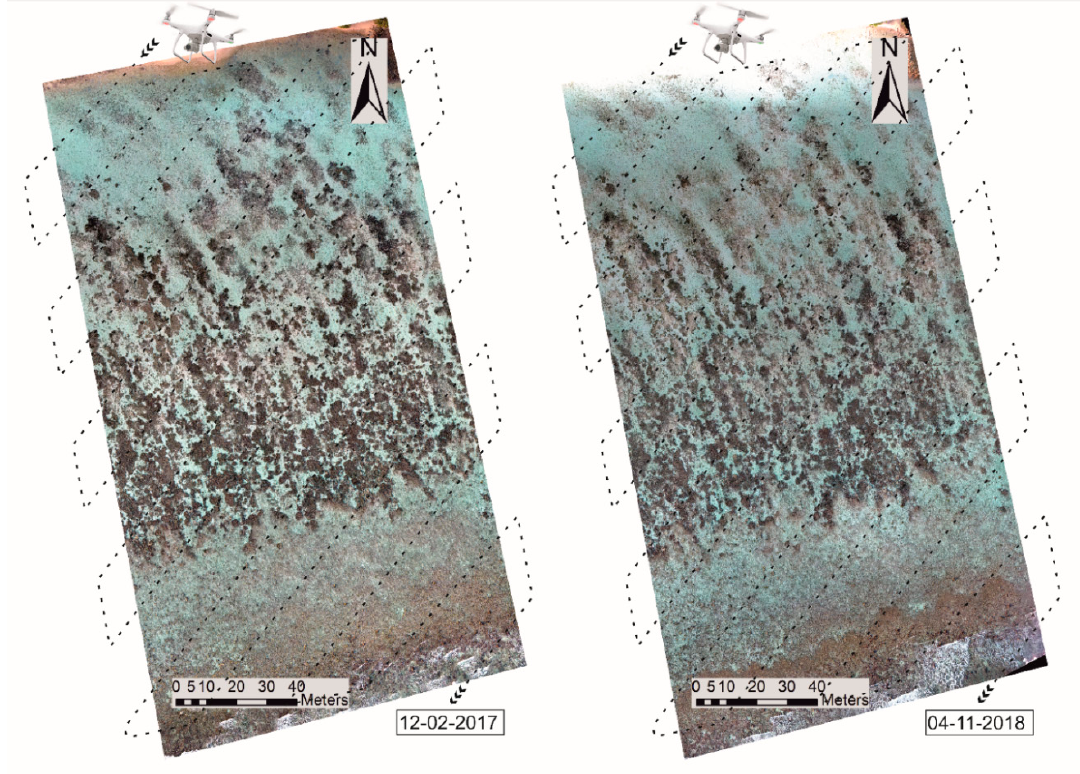
Figure 2. Example of UAV flight paths over Area 2 in 2017 and 2018. The surveys were carried out with similar environmental conditions: low tide, little wind and during the late afternoon (one hour before the sunset).